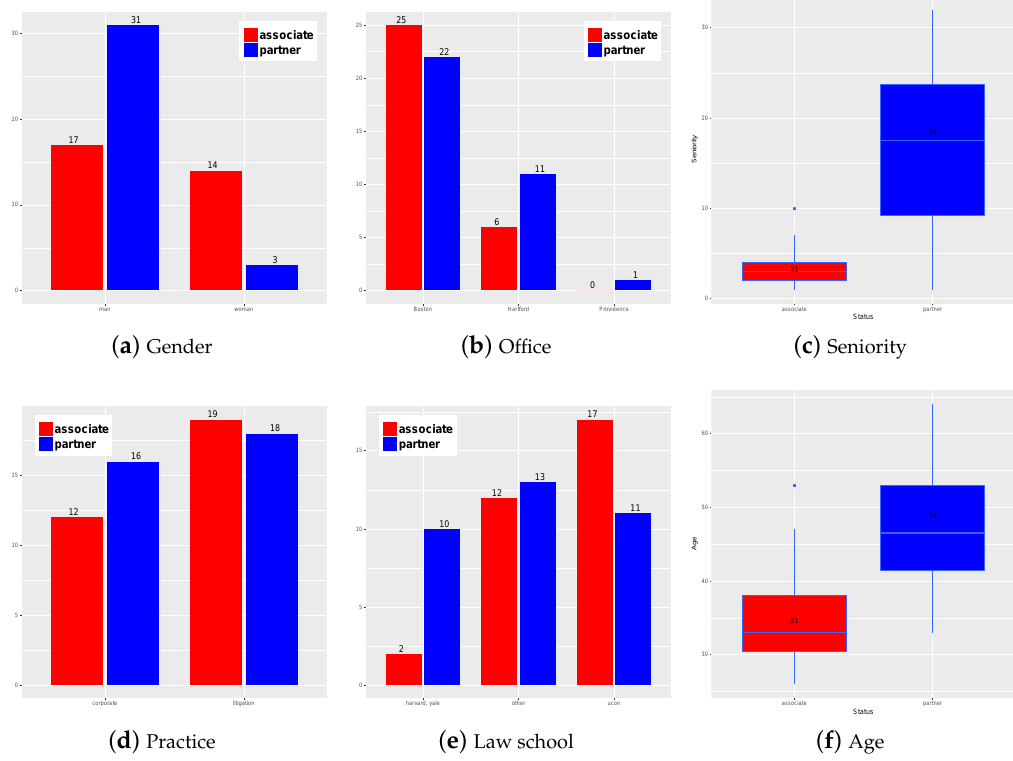
Figure 3. The left four panels are the grouped bar charts of status versus the four categorical features: “gender”, “office”, “practice”, and “law school”. The right two panels are the box-plots of “status” versus the two count variables “seniority” and “age”.